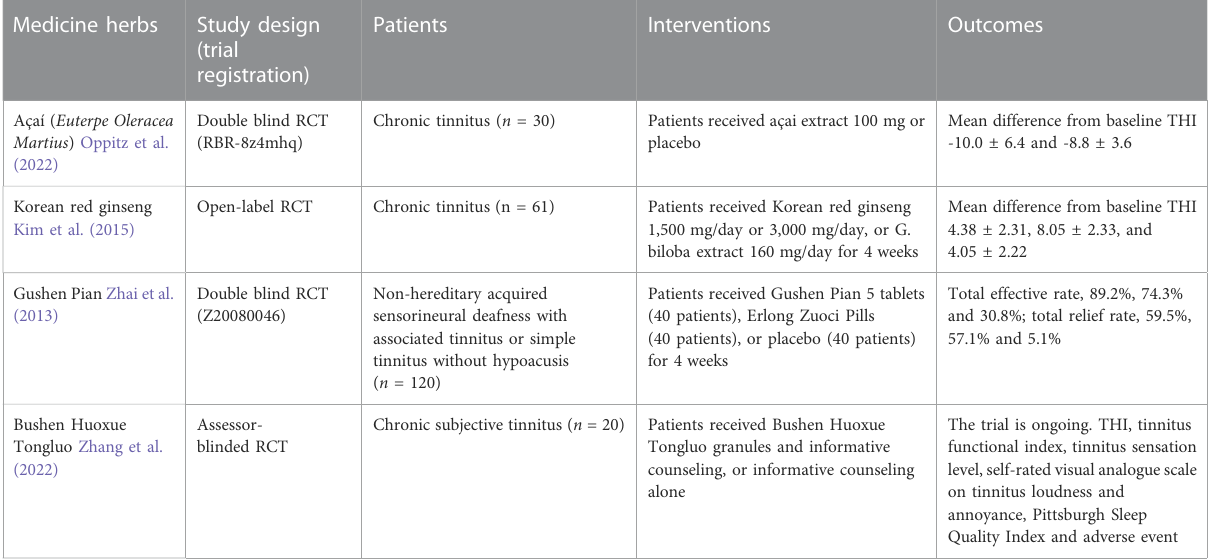
TABLE 3 Herbal Medicines other than G. biloba in the Treatment of Tinnitus. Medicine